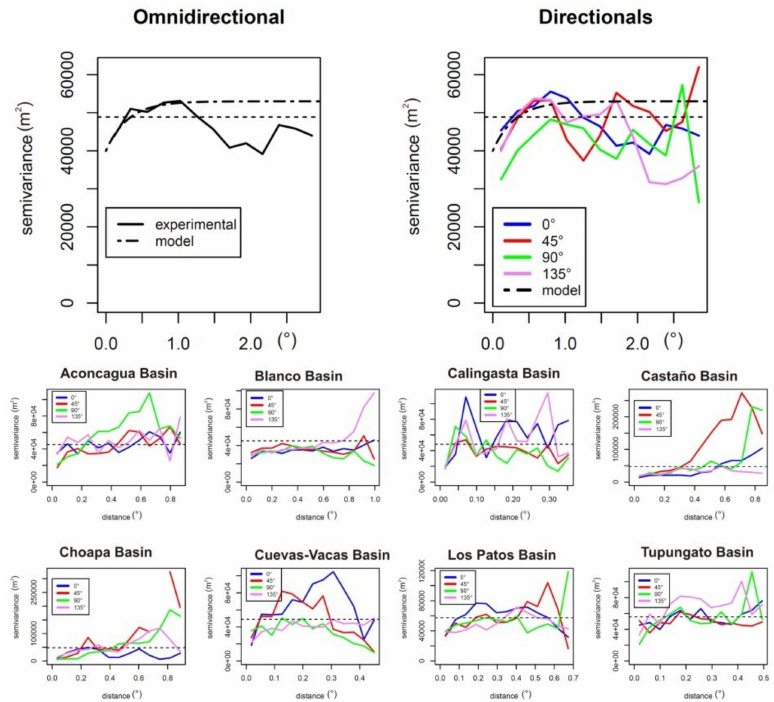
Figure 6. Omnidirectional and directional semivariograms of the whole study area and differentiated according to the basin. The x-axis in all the graphs indicates the distance expressed in decimal degrees. Note that in the latitudinal direction, one-degree represents 111.3 Km, while in the longitudinal direction, this relationship changes. At 30 ◦ and 35 ◦ south latitude, one-degree represents 96.4 and 91.2 Km,